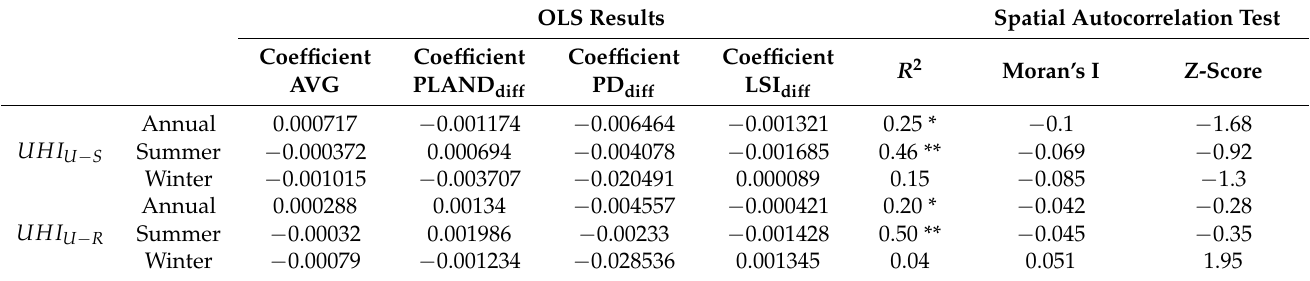
Table 1. OLS results between UBAEI s and SloFLs for different seasons. Asterisks “**” and “*” indicate 0.01 and 0.05 significance levels,